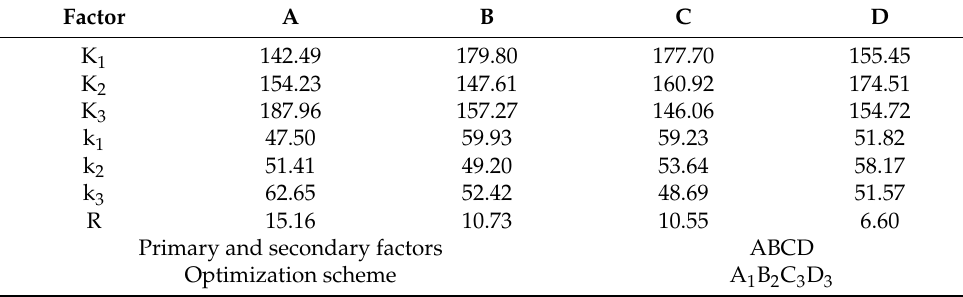
Table 5. The orthogonal experimental analysis regarding t 90% .